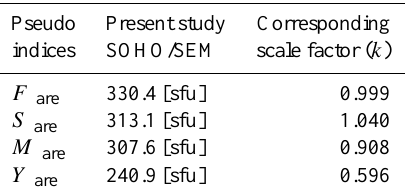
Table 3. Estimated pseudo solar indices and corresponding scaling factors for the X17.2 solar flare in 2003 using SOHO/SEM obser- vations.